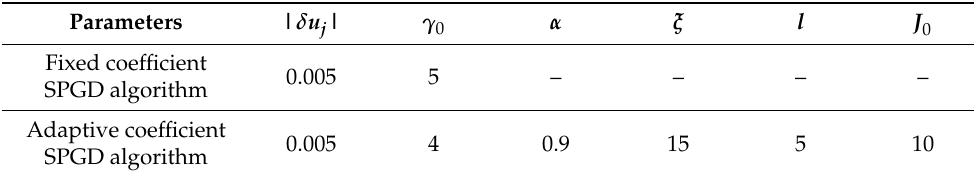
Table 1. Parameters used in the experiments